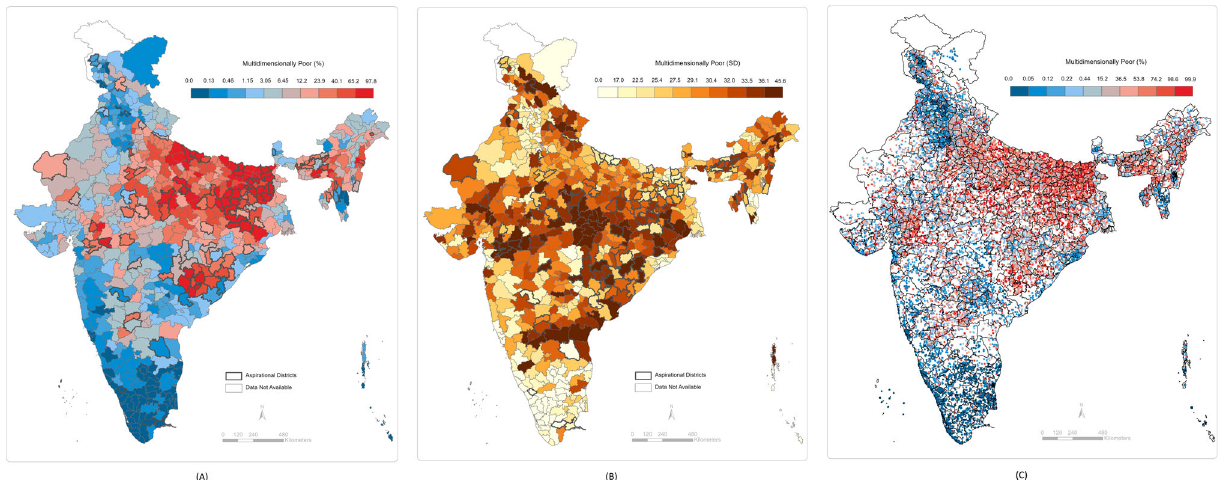
Fig. 8 Small area maps of MDP households throughout India. A Geographic prevalence of MDP individuals across 640 districts in India. B District-level distribution of cluster-level inequality for MDP individuals across 640 districts in India. C Geographic prevalence of MDP individuals across 24,416 clusters in